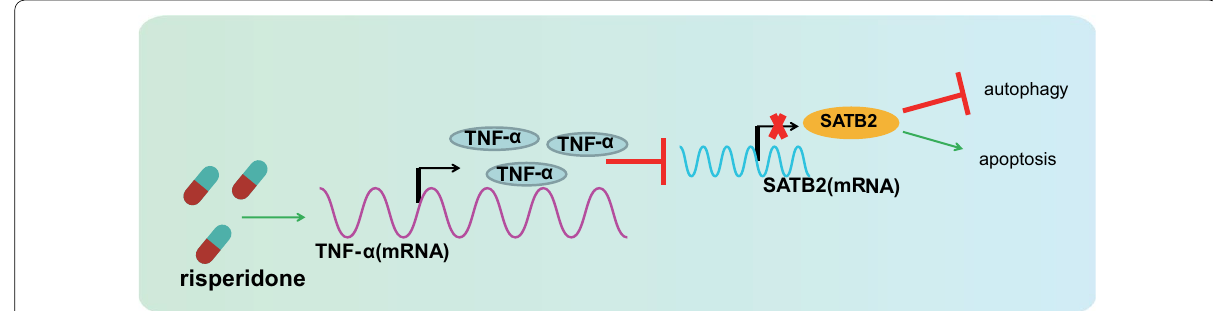
Fig. 9 Schematic diagram of the mechanism by which Risperidone affects the autophagy and apoptosis of osteoblasts. Risperidone promotes TNF-α expression to represses SATB2 expression, thus inhibiting autophagy and enhancing apoptosis of osteoblasts, ultimately arresting osteoblast